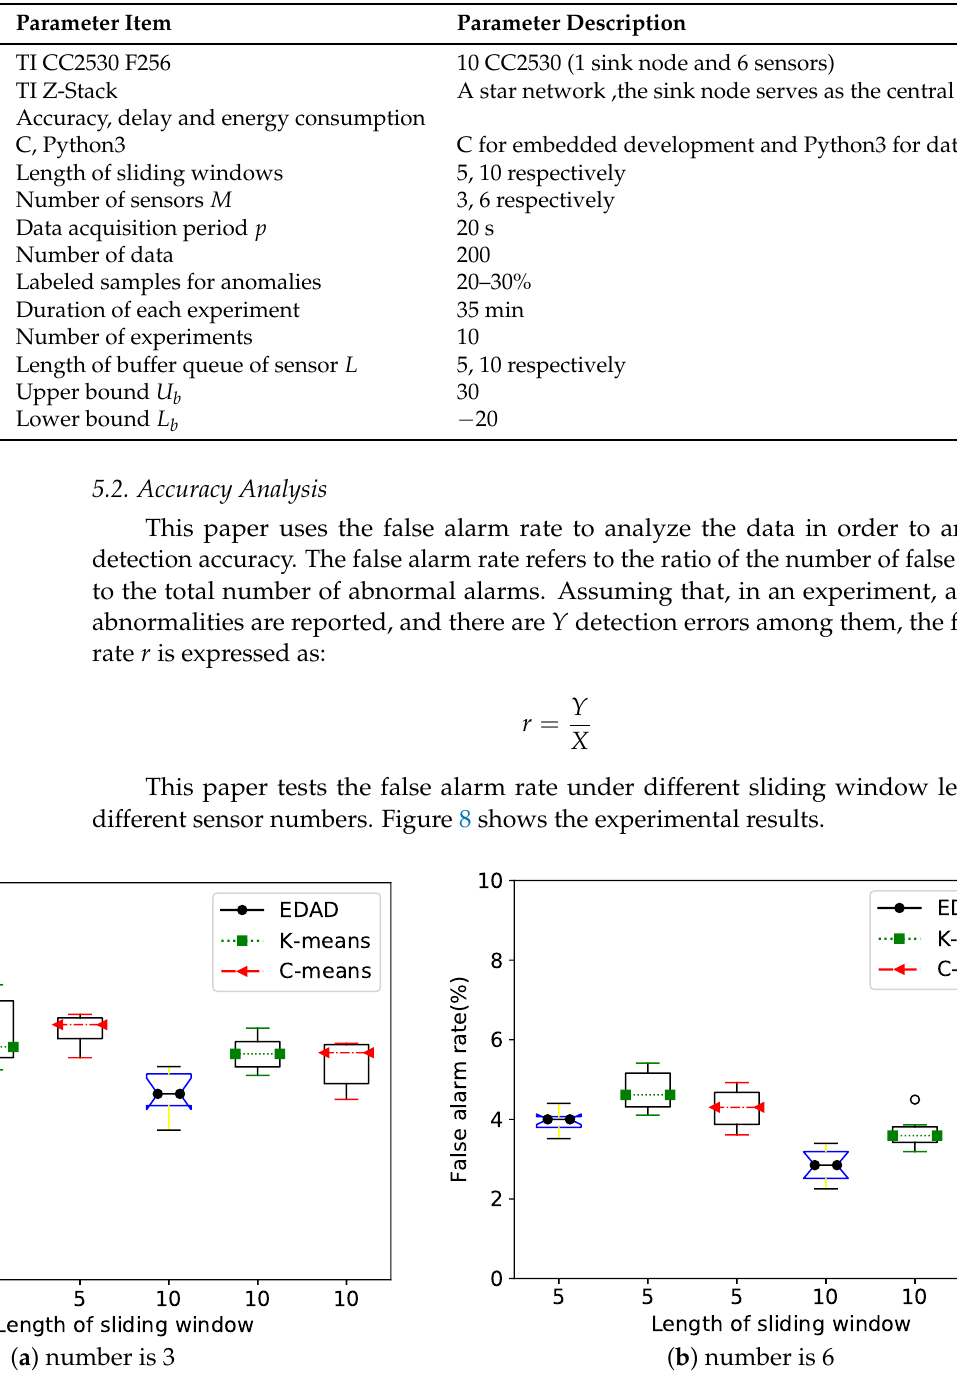
Figure 8. False alarm rate experiment result under different sliding window lengths and different sensor